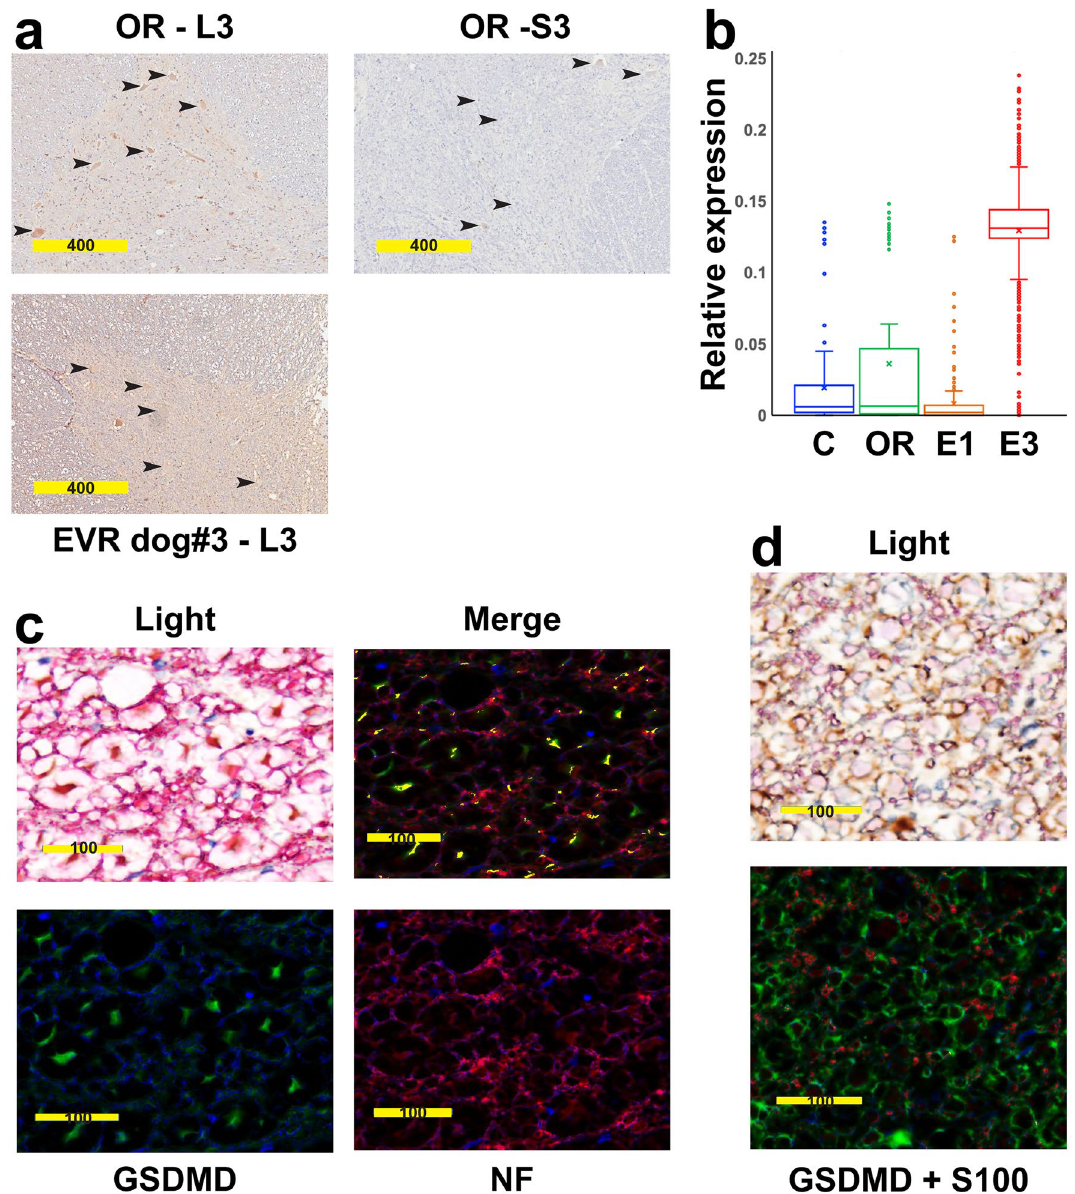
Figure 4. The SC of EVR and OR dogs express different markers of cell death. ( a ) IHC for Parp3 (brown) on cross-sections at L3 and S3 levels in an OR dog (top left and right panels, respectively), and at L3 in EVR dog#3. Arrowheads point at motor neurons. ( b ) Box and whisker plots showing Gasdermin D expression assessed by IHC on multiple lumbar cross-sections of a control dog (C), an OR dog, and EVR dog #1 (E1) and dog#3 (E3). The cross gives the mean value. ( c ) Bright field (upper left panel) and immunofluorescence (three other panels) showing co-localization between Gasdermin D (GSDMD, green) and neurofilament heavy polypeptide (NF, red) on L5 cross-sections from EVR dog#3. Yellow: co-expression. ( d ) Bright field (upper panel) and immunofluorescence (lower panel) showing lack of co-localization between Gasdermin D (GSDMD, green) and S100 (oligodendroglial marker, red) on L5 cross-sections from EVR dog#3. Scale bars are in